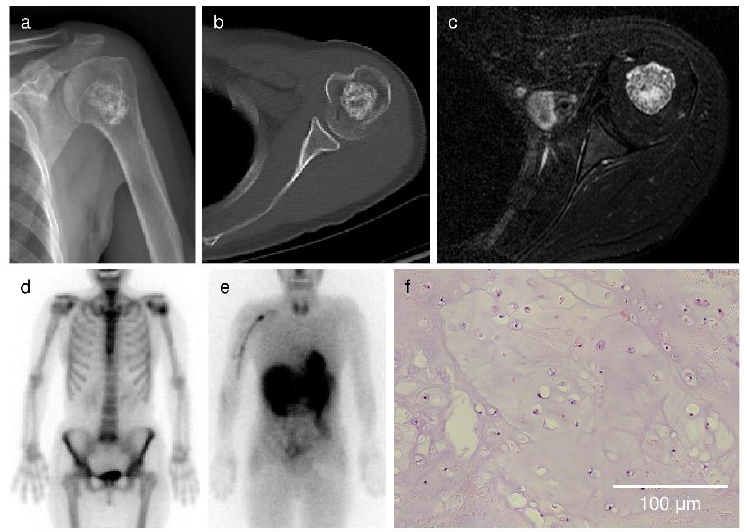
Figure 3. Case 1. A 58-year-old woman presenting with shoulder pain. ( a ) Radiograph showed no periosteal reaction in the proximal humerus. ( b ) There was no endosteal scalloping or cortical defect on CT. ( c ) MRI showed no extraskeletal mass, multilobular lesion, or abnormal signal in adjacent tissue. ( d ) The bone scan demonstrates uptake of 99m Tc-MDP in the proximal humerus, but the up- take was not greater than uptake in the anterior iliac crest. ( e ) 201 Tl scan showed no increased uptake in the proximal humerus. Based on the results, the overall radiological score rate was calculated as follows: [0 points (X-ray) + 0 points (CT) + 0 points (MRI) + 0 points (bone scan) + 0 points ( 201 Tl scan)]/16 points (full marks) × 100 = 0%. ( f ) The microscopic image shows hypocellular tumor cells with an abundance of hyaline cartilage matrix. No cytological atypia or mitosis was observed. The final histological diagnosis was enchondroma.